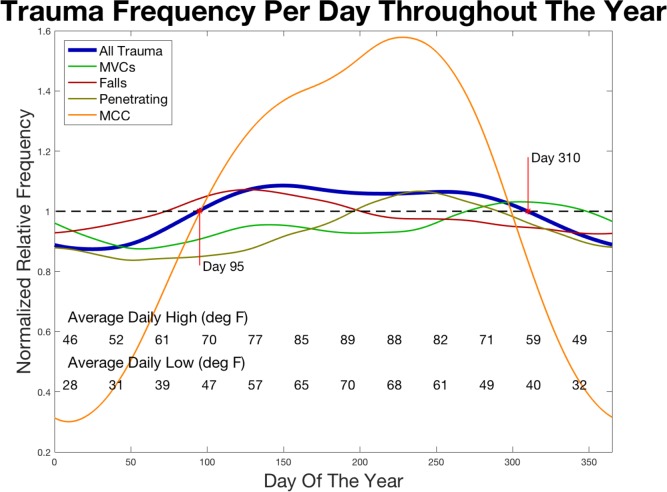
Smoothed, normalized relative trauma frequency per day throughout the year.All trauma (blue) shows above-median trauma during mid year. Several of mechanisms of injury (see legend) are considered additionally. The first point marks the date (day 95: April 5th) that this institution tends to see its median number of traumas. The second point (day 310: November 6th) denotes the end of the above-median yearly peak in trauma contacts per day.